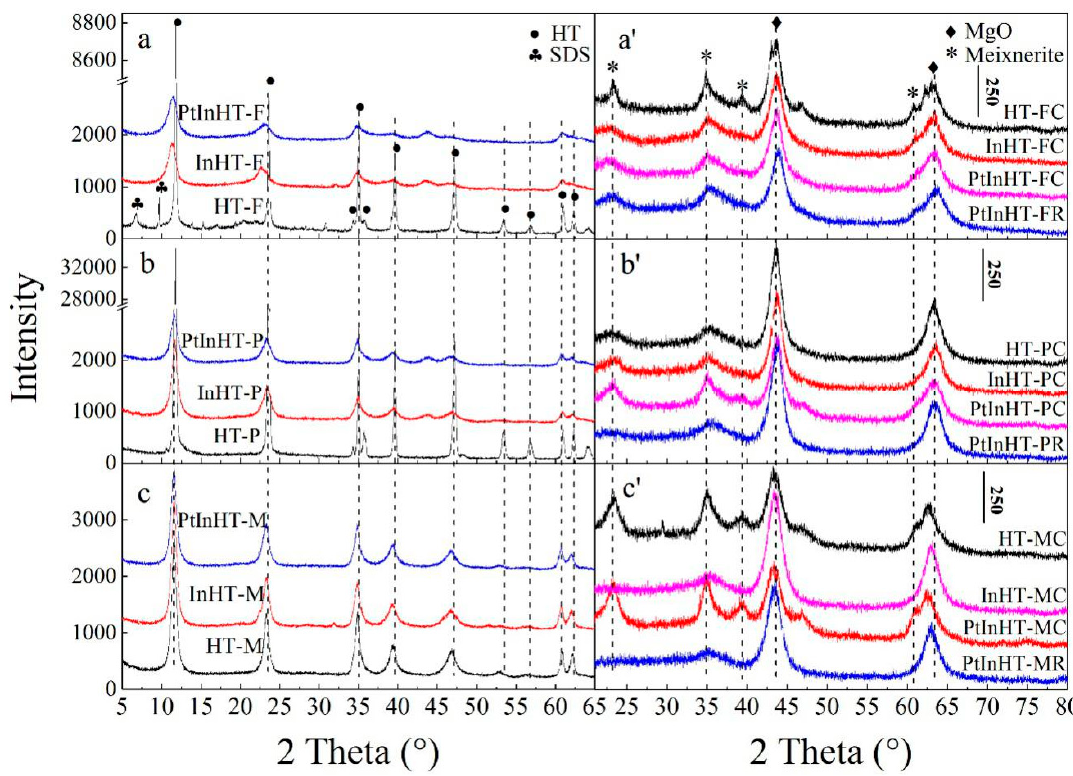
Figure 1. XRD patterns of HT precursors and derived samples in different morphology. Table 1. Lattice parameters of HT phase in all dried samples.